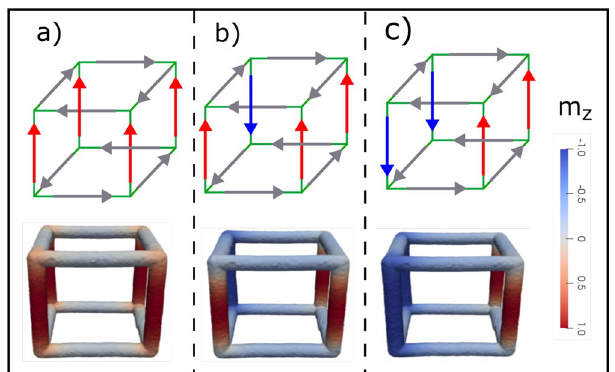
Figure 6. ( a – c ) Show the magnetic profile observed during the magnetic reversion considering magnetic field values of − 220 mT, − 358 mT, and − 366 mT,